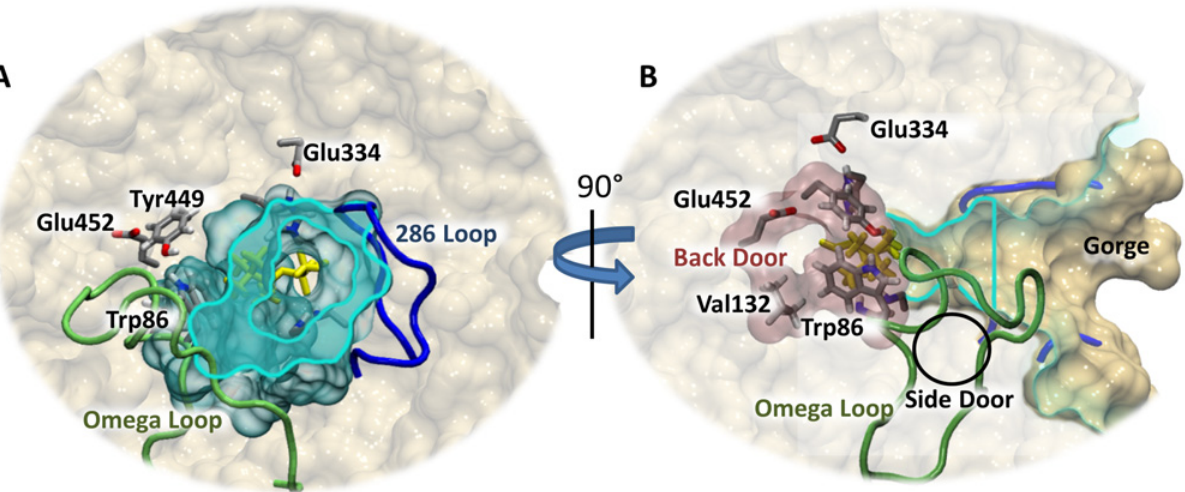
Fig 4. The surface of human AChE structure viewed from the (A) gorge entrance, (B) rotated 90° to the right, and (C) from the back door surface. The soman adduct is shown in spheres colored by atom name. The soman residue is at the bottom of the gorge (A), which is represented by a gray transparent surface. This gorge surface is cut at the cyan colored outline. This cut is also shown as a vertical line in part (B). Loop 286 – 298 (blue), Omega loop (green), and back door are proposed product exit paths in human AChE. The gorge is highlighted in cyan with the horizontal line in (B) showing the clipping plane in (A). The back door exit gate is composed of residues Trp86 and Tyr449 (shown as sticks). The opening to the back door, which has been described as a dimple on the surface of the protein [13] is defined by residues Val132, Tyr449, and Glu452 (shown as sticks). Figure created with VMD [11], Tachyon [12], and GIMP.